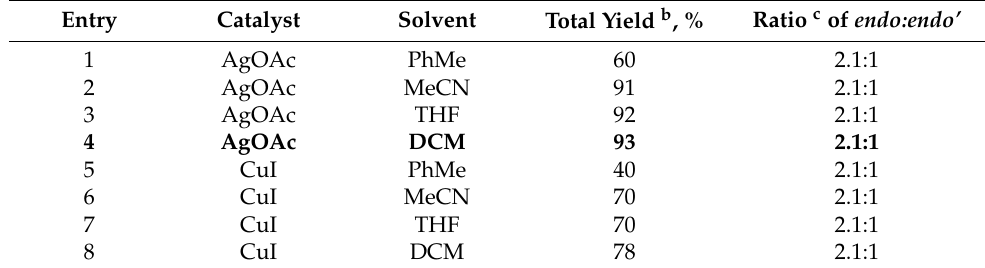
Table 2). The donor-acceptor properties of substituents in chromene 4 and in the aryl fragment of the α -iminoester 5 had no significant effect on the yields of products 8 and the diastereoselectivity of the reaction. Individual isomers endo - 8a − g and endo’ - 8a − g in 54–61% and 20–27% yields, respectively, were prepared after the purification of crude products by column chromatography.